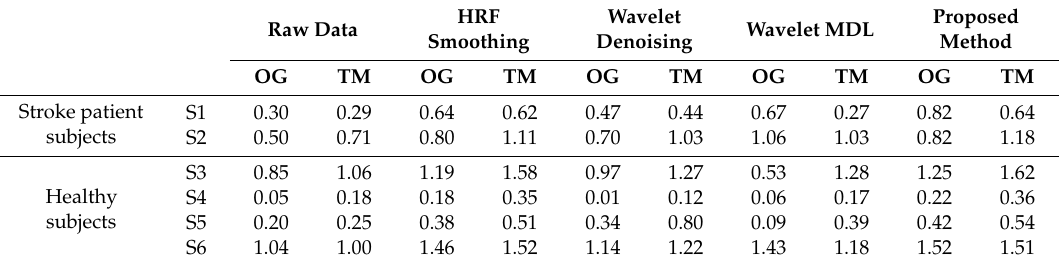
Table 1. Motion artifact correction results in comparing with the conventional and proposed methods.